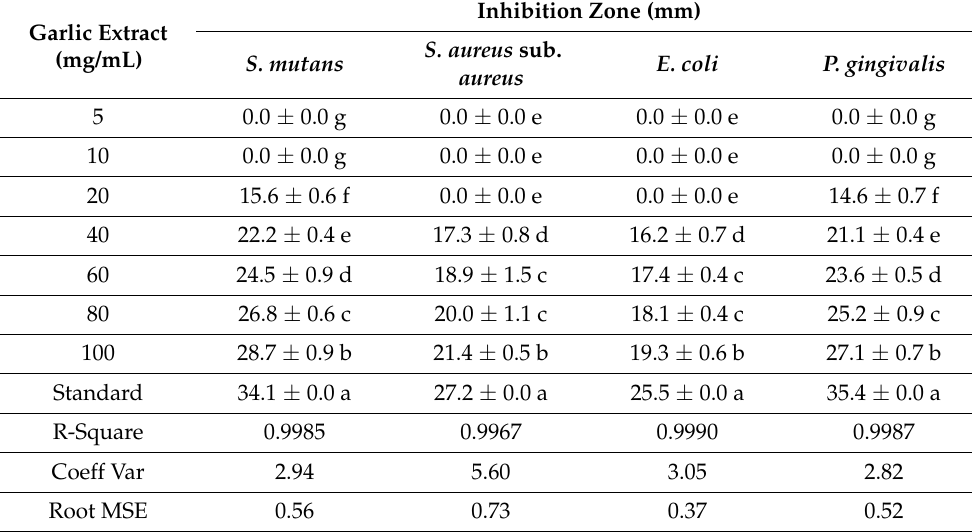
Table 2. Antibacterial activity of nanoparticles (supernatant) of garlic extract against S. mutans , S. aureus sub. Aureus , E. coli , and P. gingivalis by agar well diffusion method.